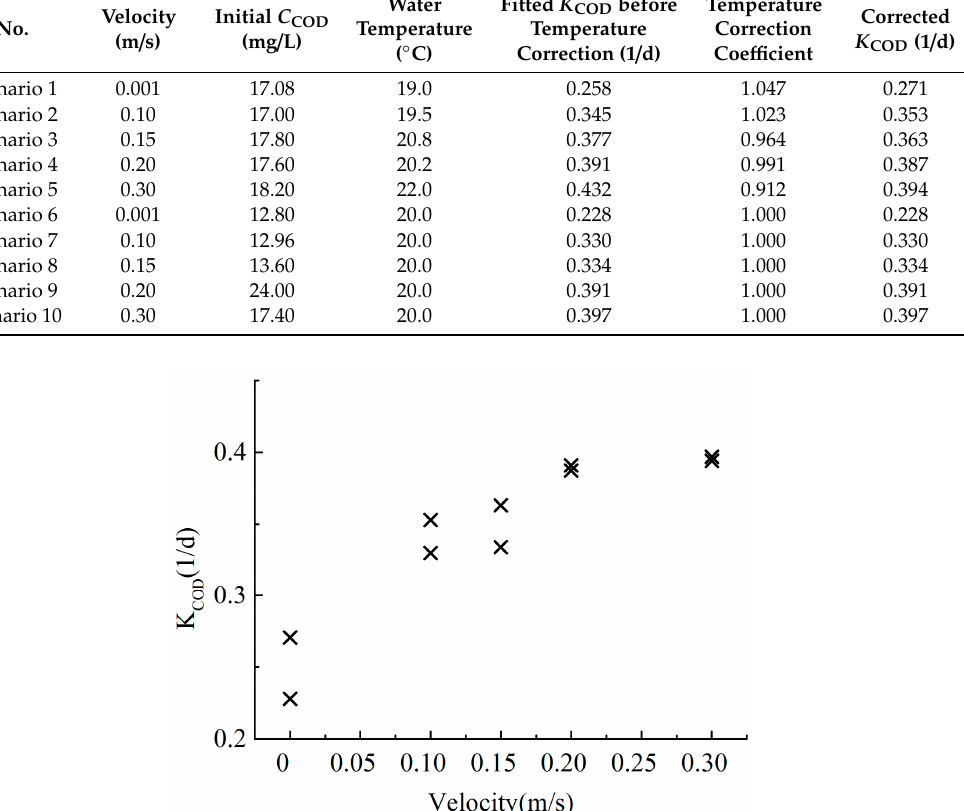
Figure 4. Relationship between K COD and the flow velocity.